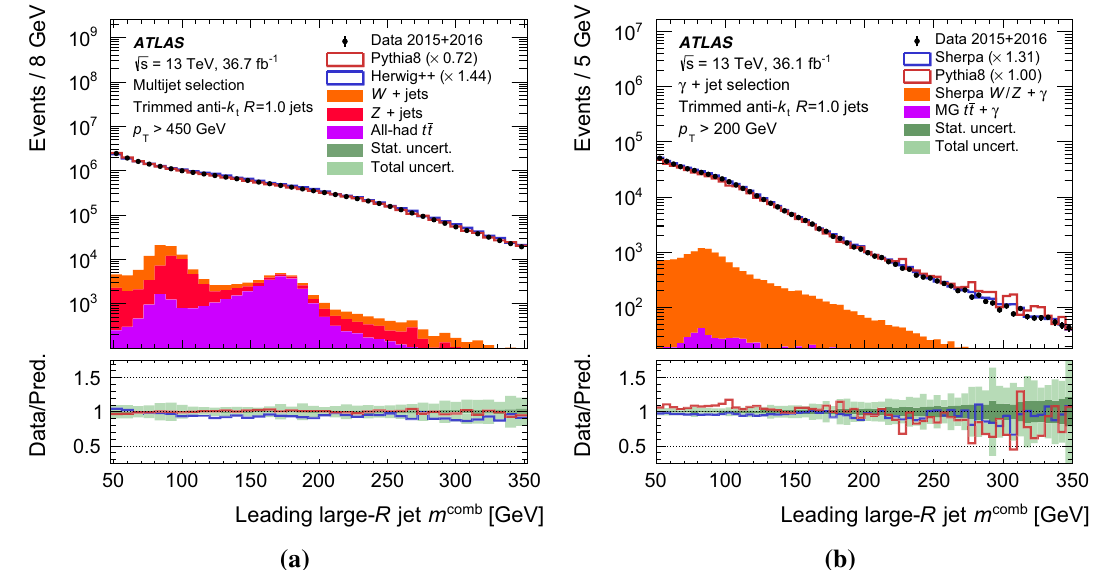
Fig. 24 A comparison of the observed data and predicted MC distribu- tions of the mass of the leading p T anti- k t trimmed jet in events for the multijet ( a ) and γ + jet ( b ) selections. The data-driven normalisation correction, described in Sect. 6.2.1, is shown in the legend beside the